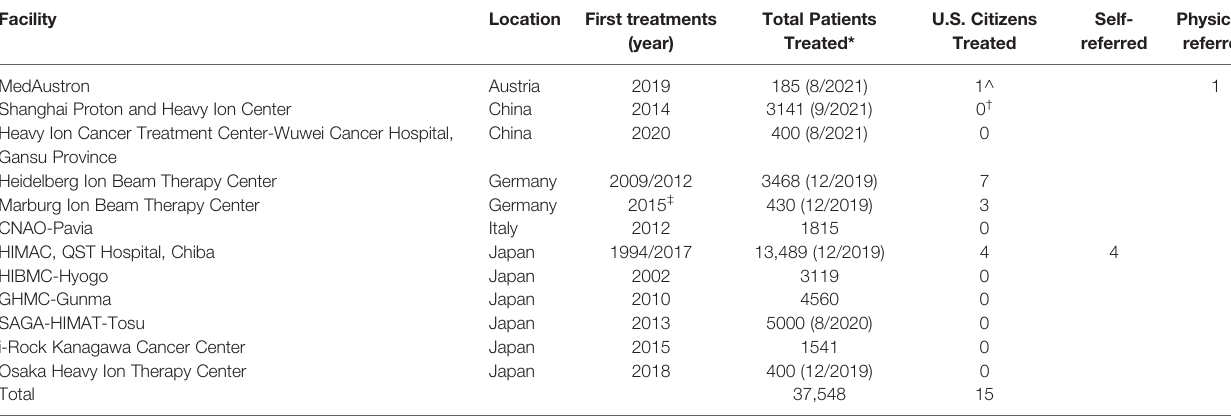
TABLE 2 | Number of U.S. Citizens Treated with